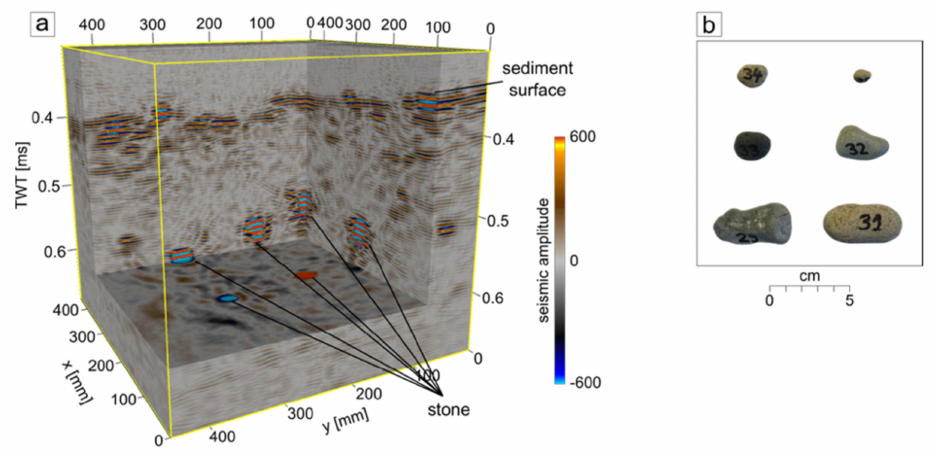
Figure 6. ( a ) Seismic volume showing the appearance of six stones in 0.5 to 0.65 ms TWT depth. All stones appear as high-amplitude reflections, with sharp lateral limits. Initially, all stones were placed in approximately the same depth, but heavier stones subsided. ( b ) Photography of the stones in the schematic configuration they are buried in. The diameters of stones are 1.9 × 1.5 × 0.9 cm and 1.1 × 1.0 × 0.8 cm ( upper row ), 2.3 × 2.8 × 1.6 cm and 3.2 × 2.2 × 1.0 cm ( middle row ),